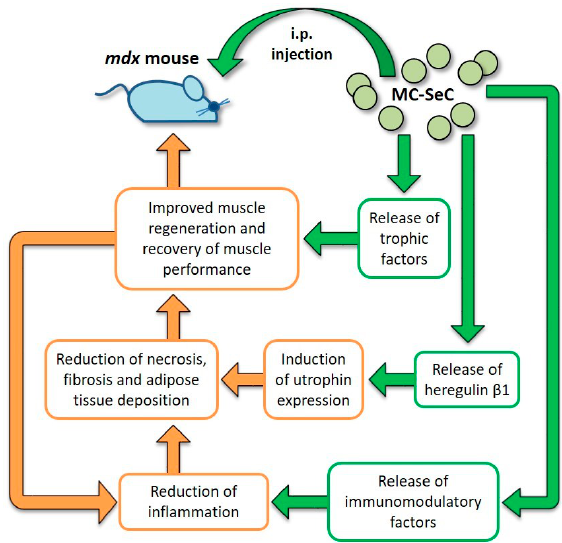
Figure 3. Diagram of the effects exerted by MC-SeC once injected i.p. into mdx mice. From inside the microcapsules, SeC release immunomodulatory factors that reduce muscle inflammation thus reducing necrosis of the myofibers, and fibrous and adipose tissue deposition. This is also favored by secretion by SeC of heregulin β 1 and subsequent heregulin β 1-dependent induction of utrophin expression. Moreover, additional SeC-derived trophic factors (such as IGF-1) might concur to improve muscle regeneration and the recovery of muscle performance, which in turn reduces local inflammation. Straight green arrows and boxes indicate secretion by MC-SeC and point to the effects of the secreted factors; orange boxes and arrows highlight the beneficial effects ignited by secreted factors.